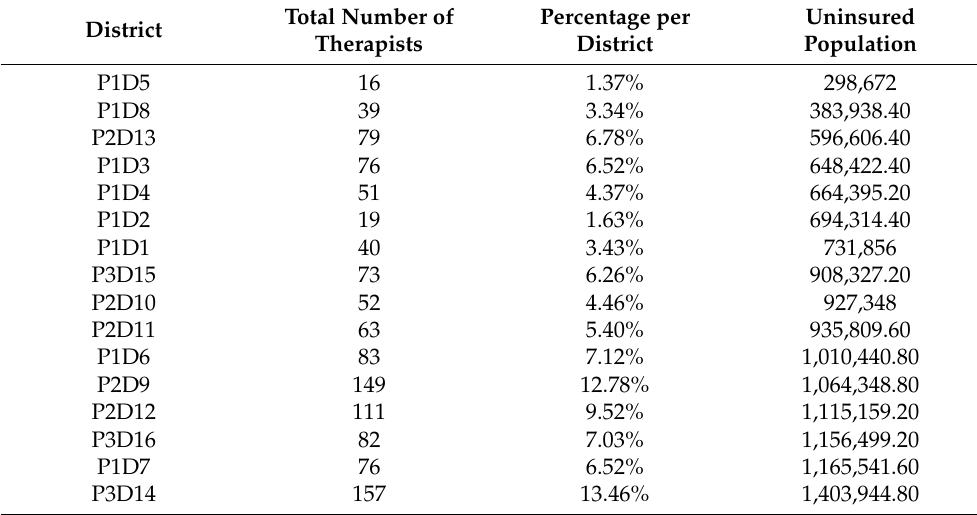
Table 5. Telephonic facility survey district